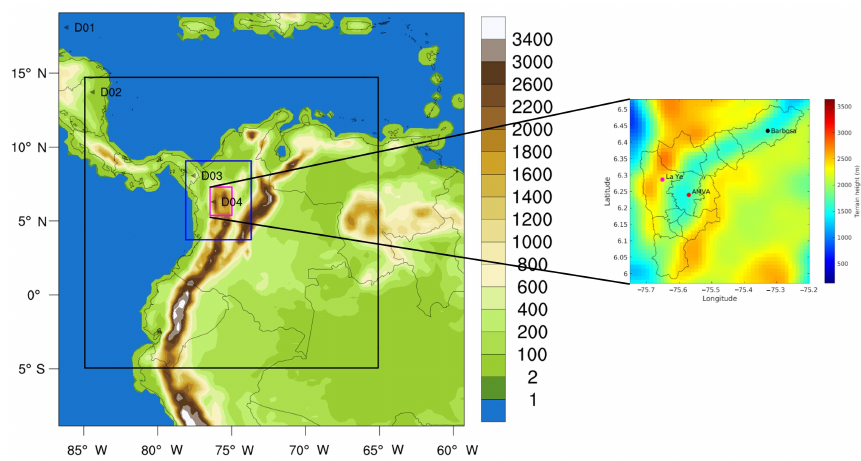
Figure 1. WRF model domains configuration: 30 km (D01), 10 km (D02), 3.3 km (D03), and 1.1 km (D04) horizontal resolution and representation of the topography in the Aburrá